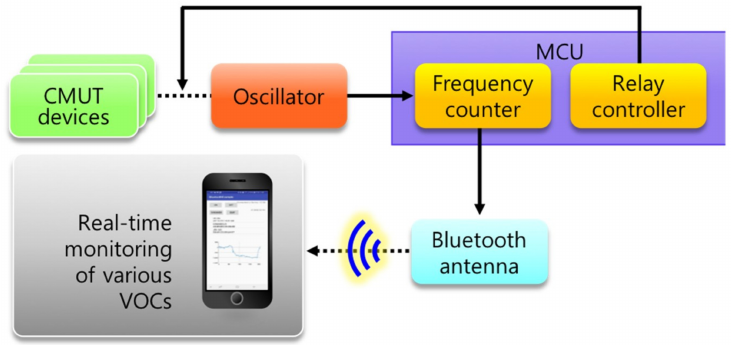
Figure 3. Block diagram of sensor interface scheme for the wireless, portable CMUT